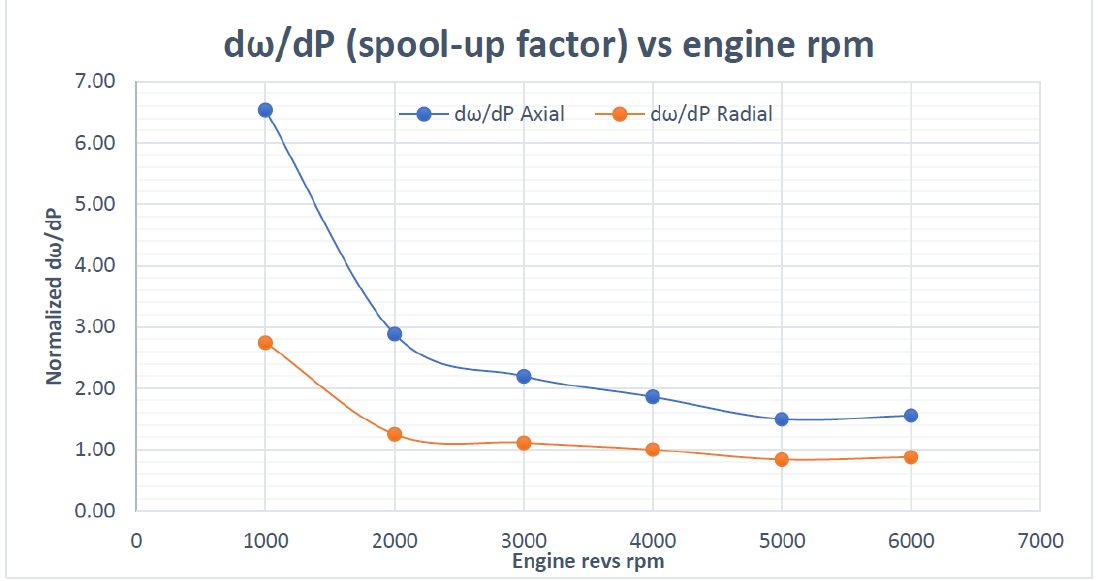
Figure 35. Comparison of the spool-up factor for the proposed axial turbine and OEM radial turbine (3D CFD).